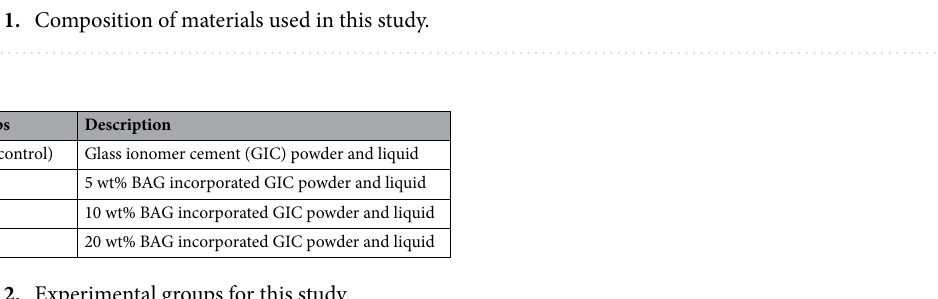
Table 2. Experimental groups for this